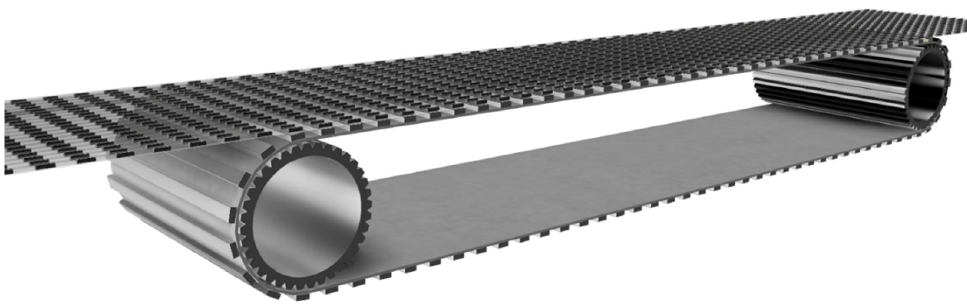
Figure 22. CAD drawing of a theoretical parallelisation using a conveyor belt.